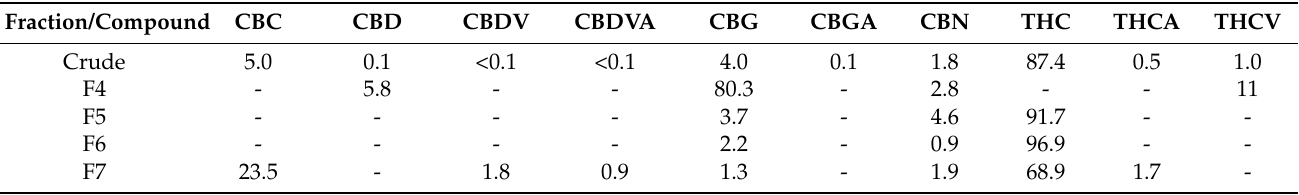
Table 1. Phytocannabinoid percentage of total phytocannabinoids in the crude DQ strain extract, and the F4–F7 frac- tionated from the extract. CBC, cannabichromene; CBD, cannabidiol; CBDV, cannabidivarin; CBDVA, cannabidivarinic acid; CBG, cannabigerol; CBGA, cannabigerolic acid; CBN, cannabinol; THC, ∆ 9–tetrahydrocannabinol; THCA, ∆ 9- tetrahydrocannabinolic acid; THCV, ∆ 9–tetrahydrocannabivarin. Fraction/Compound